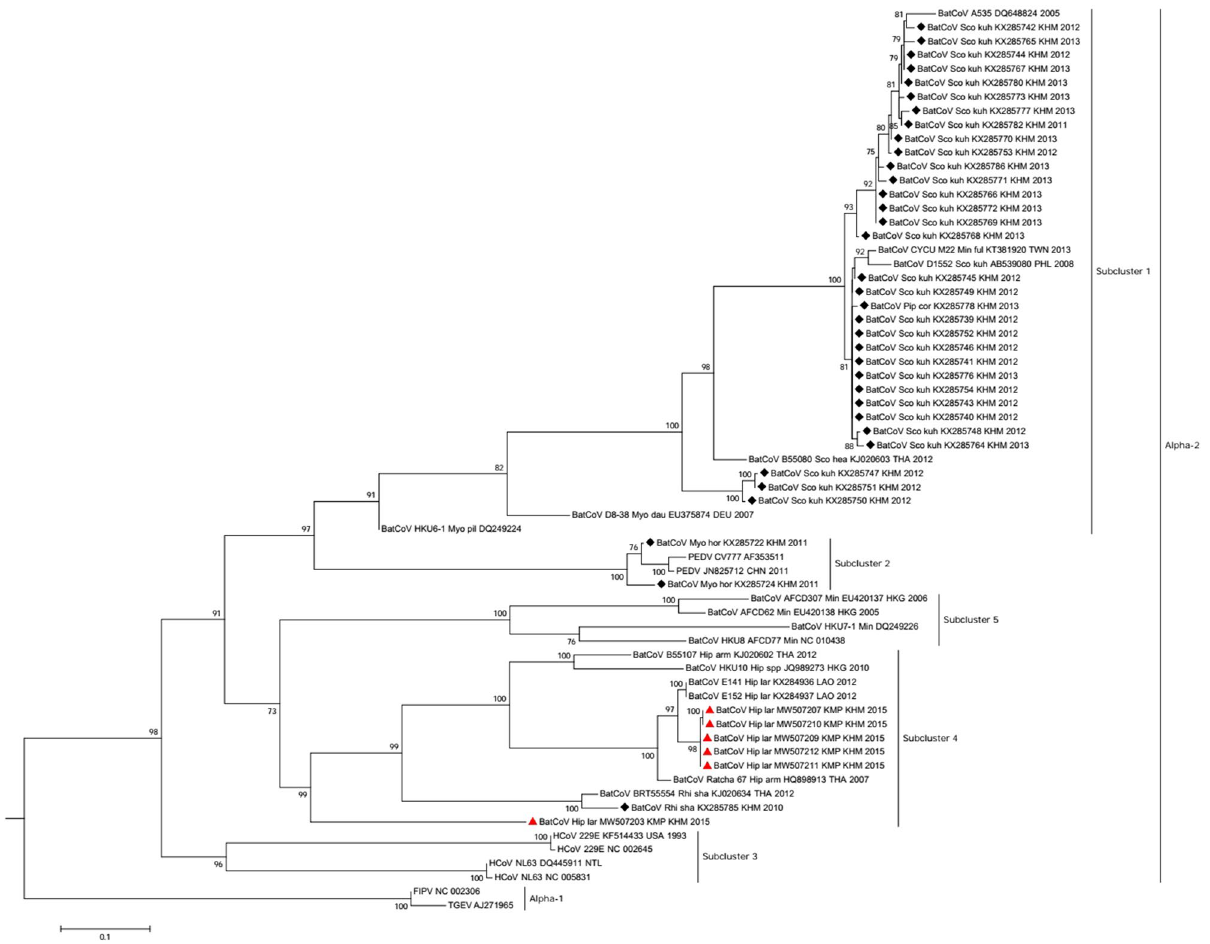
Figure 3. Phylogenetic tree of ( A ) alphaCoV and ( B ) betaCoV partial RdRp gene with modified primers. The sequences detected in Cambodia are marked by red triangles for strains in the current study and black diamonds for strains previously described by Lacroix et al. 6 . The tree was built using the maximum likelihood method based on the GTR + G4 + I model. The robustness of nodes was assessed with 1000 bootstrap replicates. Bootstrap values < 70 are not shown. The GenBank accession numbers of CoV detected in this study and included in the phylogenetic analysis are: MW507190–MW507207 and